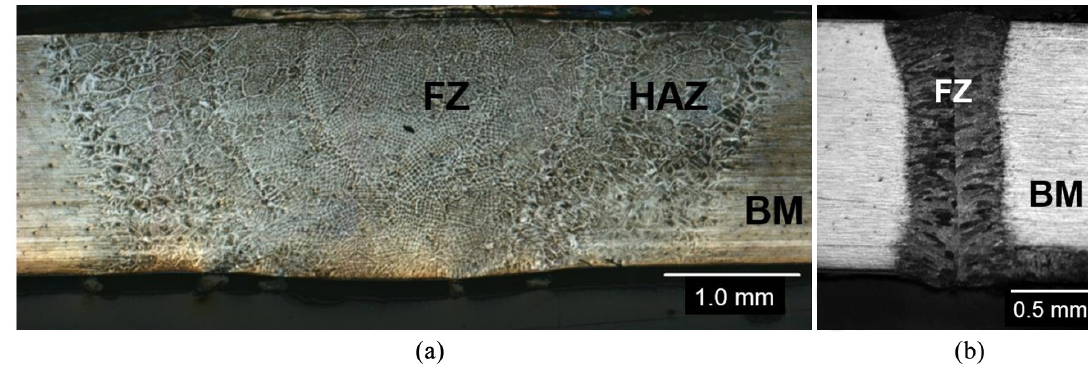
Figure 1. Microstructural features of the (a) TIG and (b) laser welding. Optical